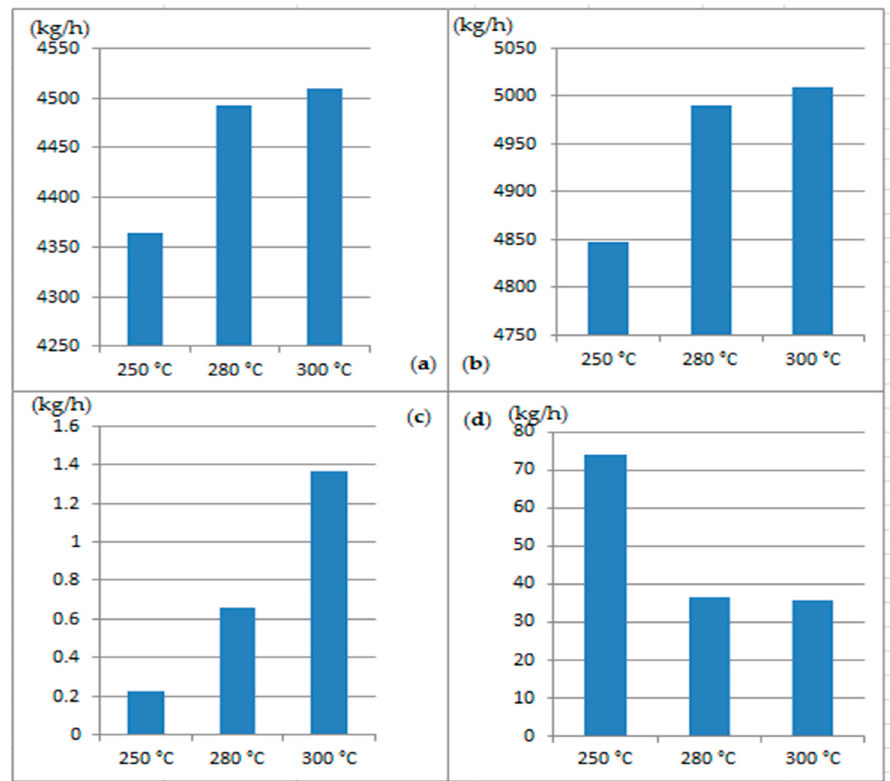
Figure 3. The mass flow at different temperatures of the mild HDO stage. ( a ) PRODUCT (model compound that represents the final product of bio-fuel, with same properties of gasoline, CH 1.71 ); ( b ) ODF (oil-phase organic compounds of mild stage, CH 1.47 O 0.11 ); ( c ) COKES (soluble coke deposit, C s ); and ( d ) COKEIS (insoluble coke deposit, C is ).